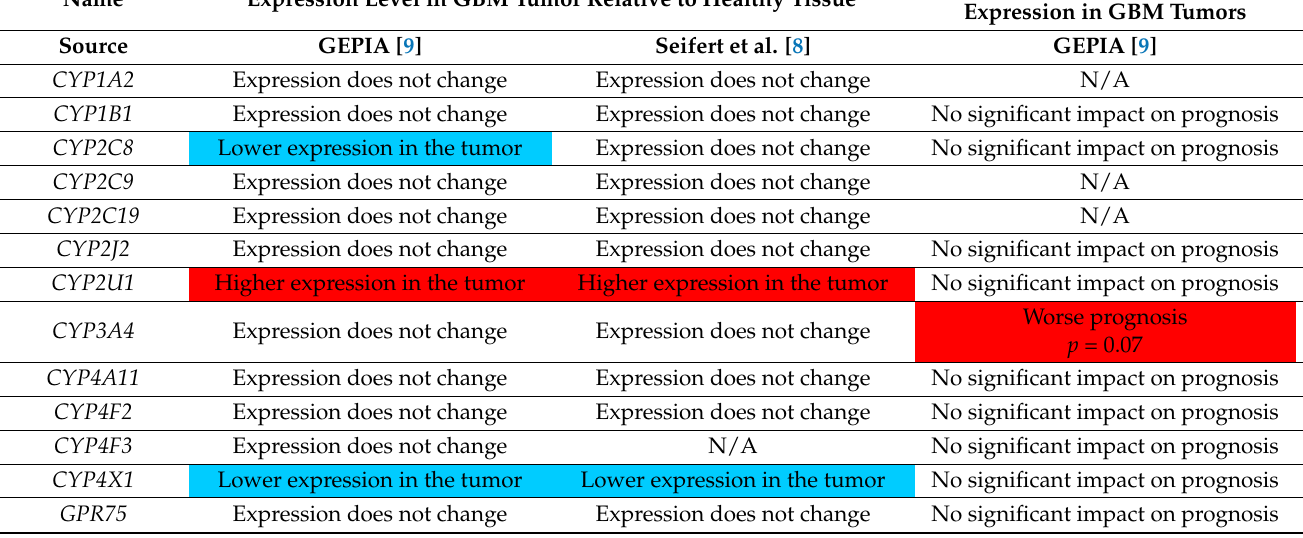
Table 9. Significance of cytochromes P450 and GPR75 receptors in ARA metabolism and tumorigenic processes in